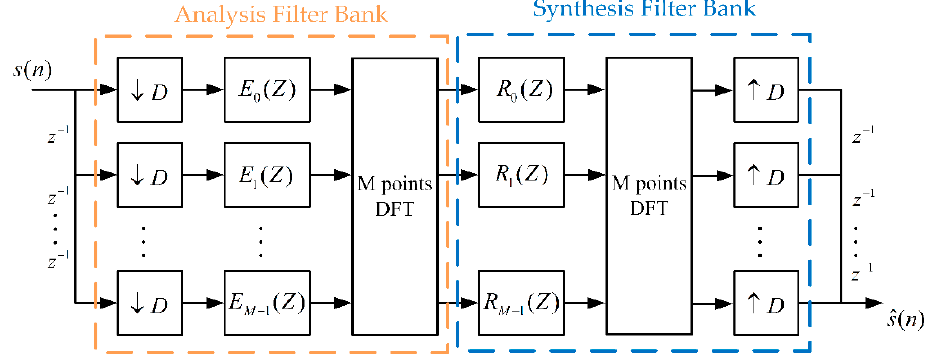
Figure 12. Efficient form of DFT filter bank.